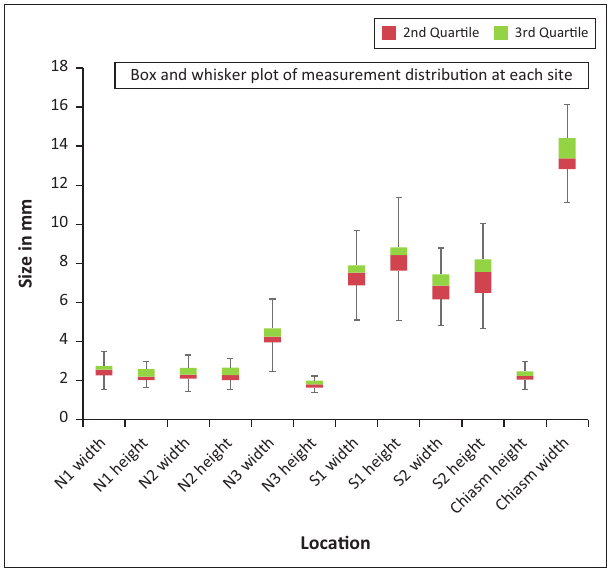
FIGURE 5: Box and whisker plot demonstrates the overall measurement distribution at different sites.